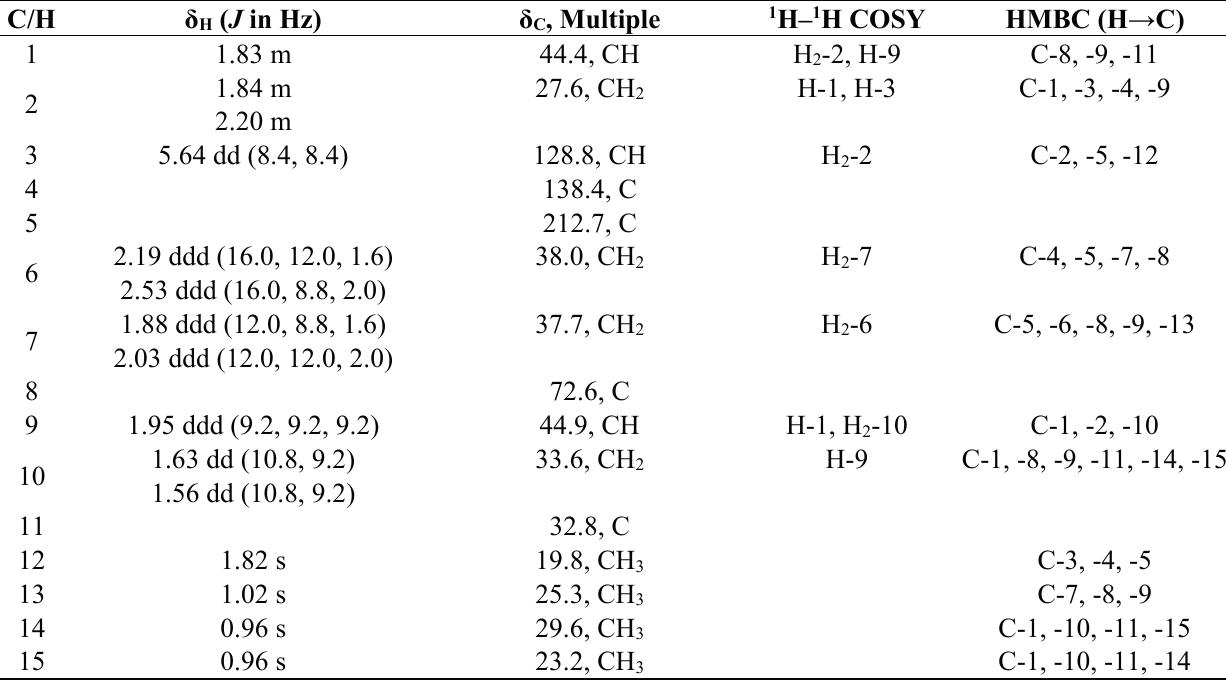
Table 1. 1 H and 13 C NMR Data, 1 H– 1 H correlation spectroscopy (COSY) and heteronuclear multiple-bond coherence (HMBC) correlations for sesquiterpenoid 1